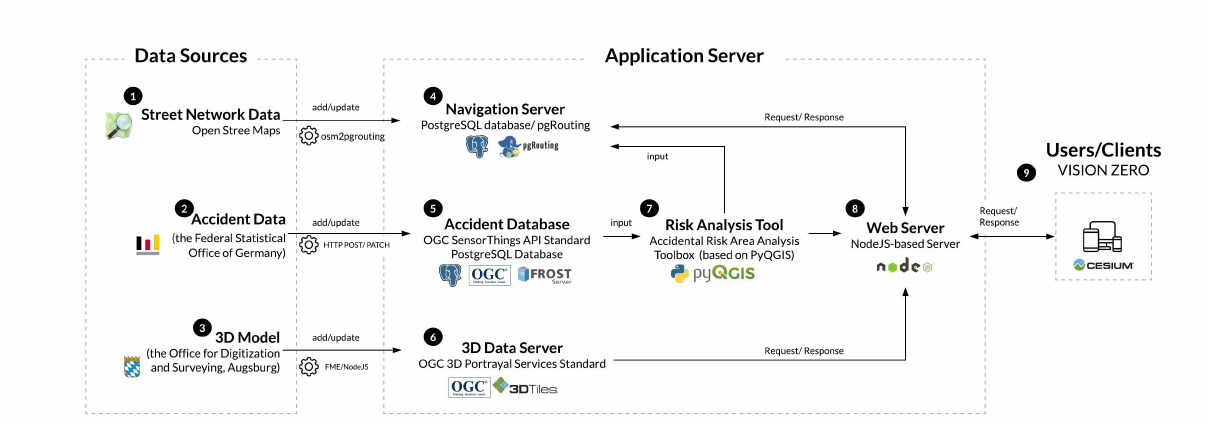
Figure 2. The overall system architecture.